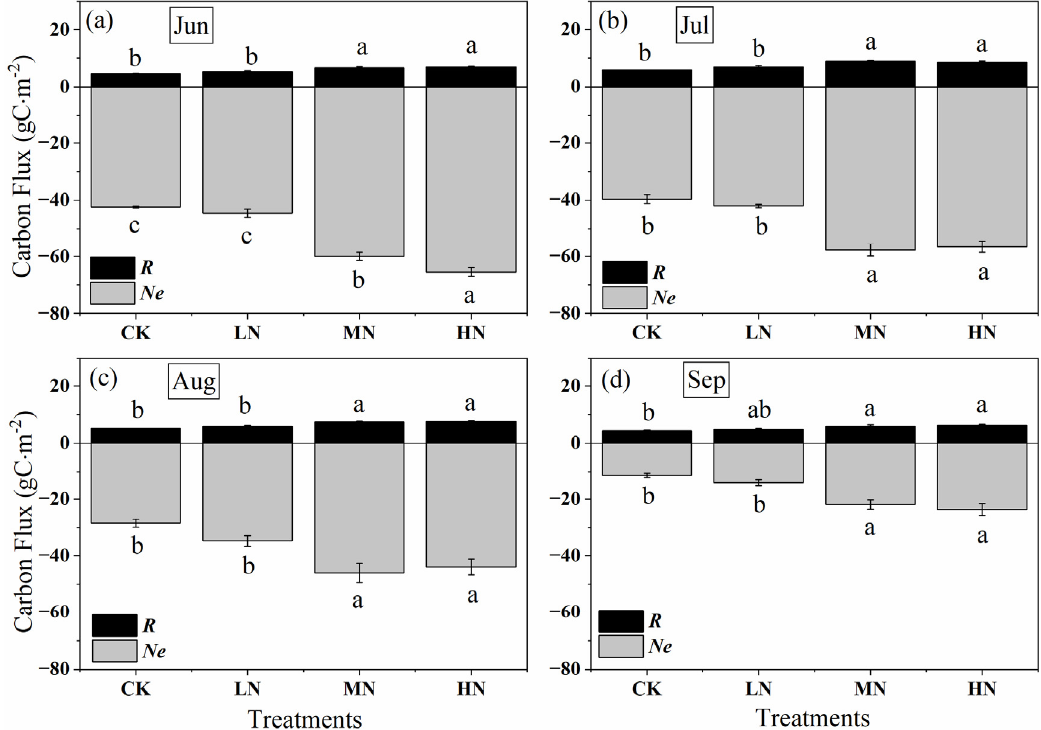
Figure 6. Monthly accumulation of net crown CO 2 exchange ( Ne , the grey column), crown respiration ( R , the black column), and gross primary production ( GPP , the total length of the grey and black column) after nitrogen addition and the control during the growing season from ( a – d ) June to September. CK, LN, MN and HN represent control (no nitrogen addition), low nitrogen addition (23 kgN · hm − 2 · a − 1 ), medium nitrogen addition (46 kgN · hm − 2 · a − 1 ) and high nitrogen addition (69 kgN · hm − 2 · a − 1 ), respectively. Letters (a, b, or c) suggest significant differences between treatments at α = 0.05.